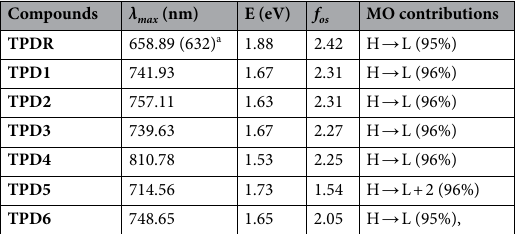
Table 3. Wavelength ( λ max ), excitation energy ( E ) and oscillator strength ( f os ) of investigated compounds in chloroform. MO molecular orbital, H HOMO, L LUMO. a Exp. value in parentheses 30 .